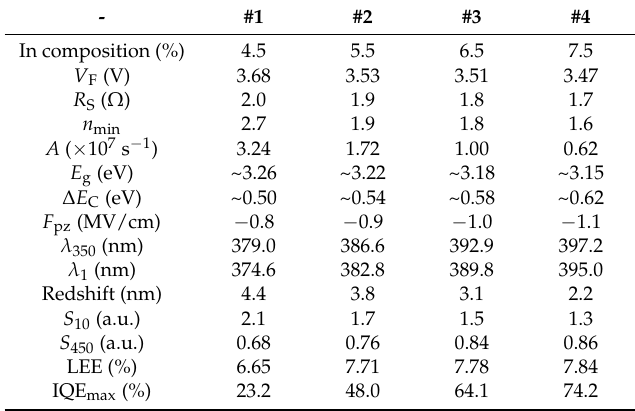
Table 1. Device characteristics of the near-ultraviolet (NUV) LED samples under study. V F